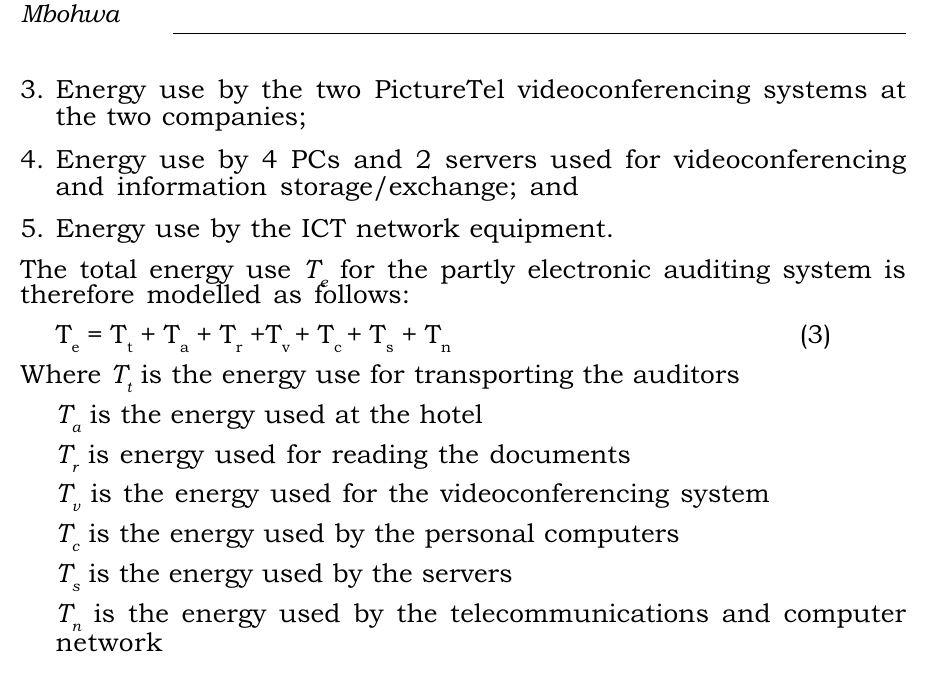
Figure 3: Configuration of the electronic audit